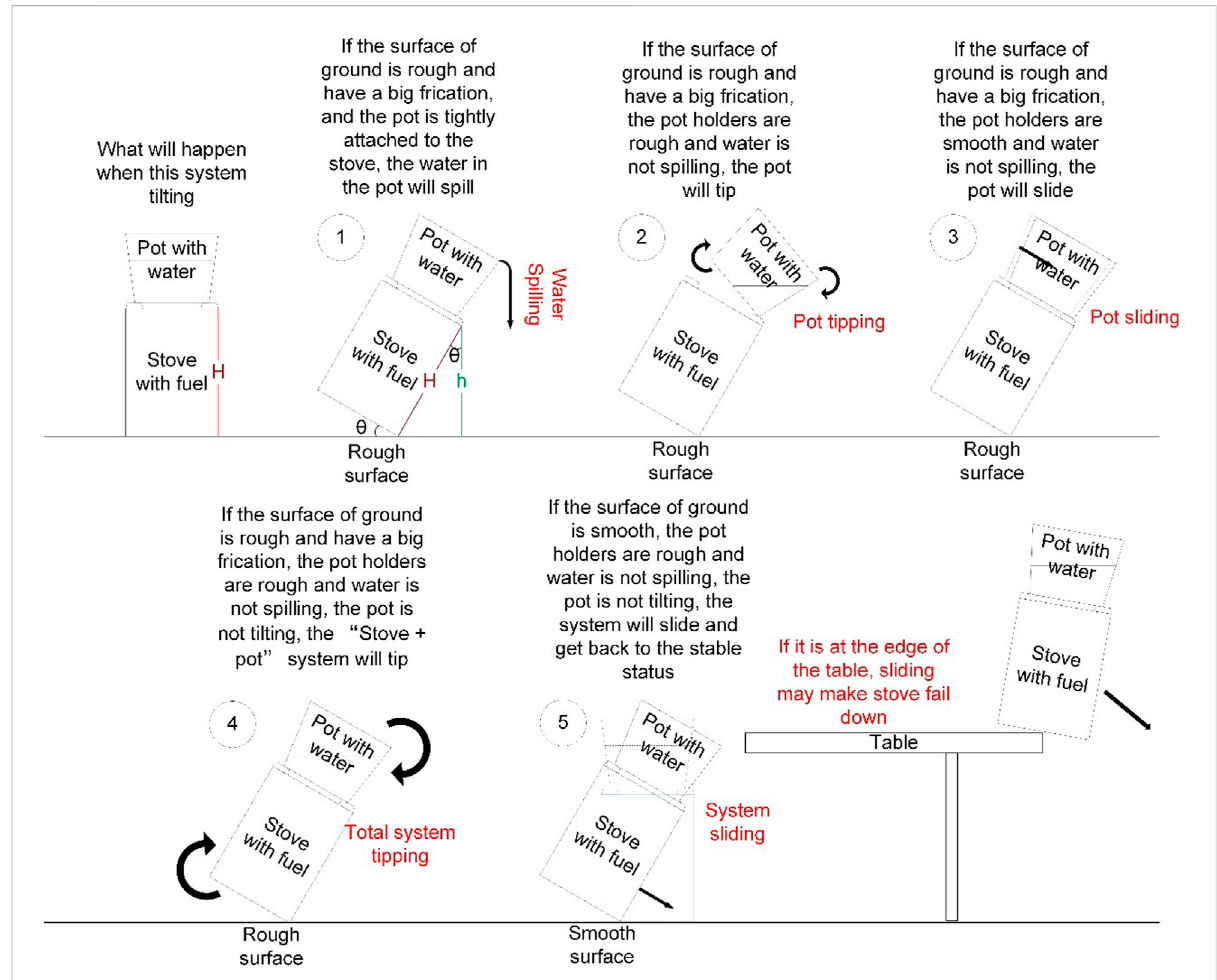
FIGURE 1 Failure modes when tilting with the pot and fuel. With the increase in the angle, fi ve situations may occur for the stove + pot